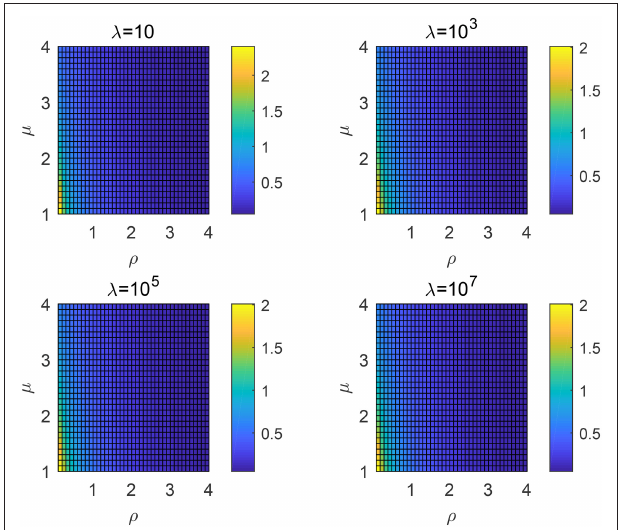
FIGURE 5 | Searching efficiency ηλ for different order µ and ρ : the destructive case with different λ